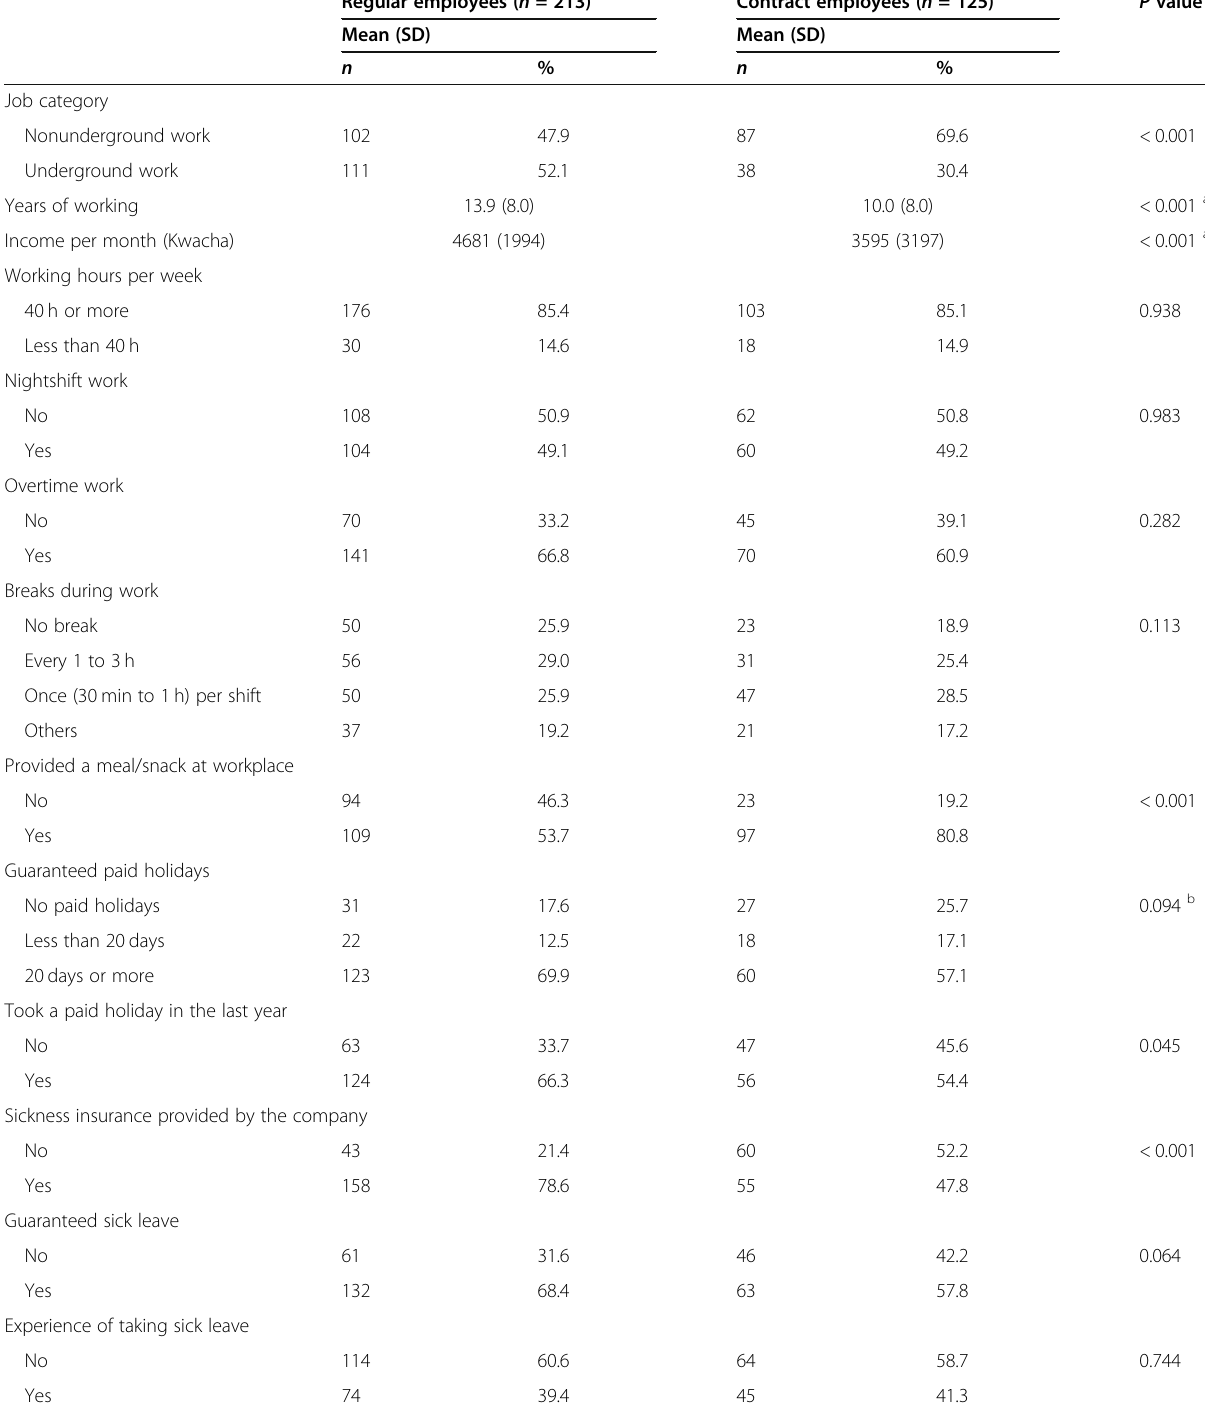
Table 2 Working conditions of the study participants ( n =